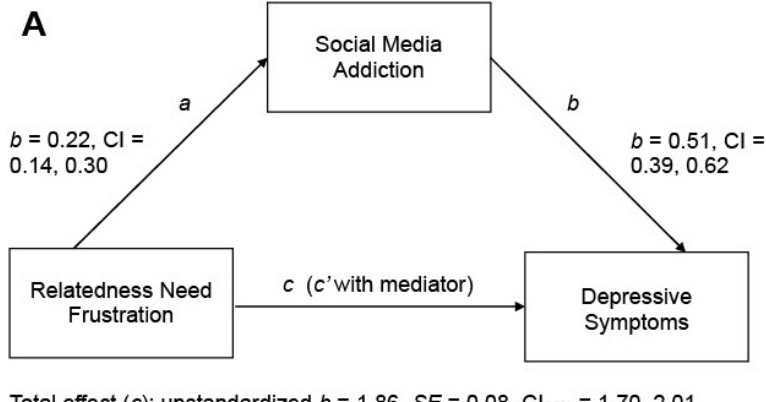
Table 2. Zero-order Pearson correlations among the study variables ( n = 1048).